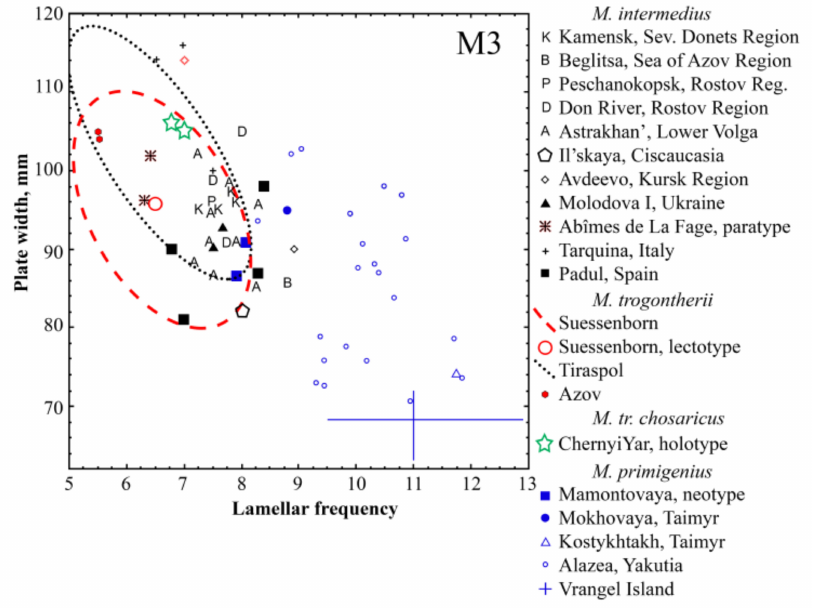
Figure 10. Ratio of the lamellar frequency and the width of the enamel plates on the upper M3 of Mammuthus intermedius from the Lower Don region compared to the other representatives of the genus Mammuthus